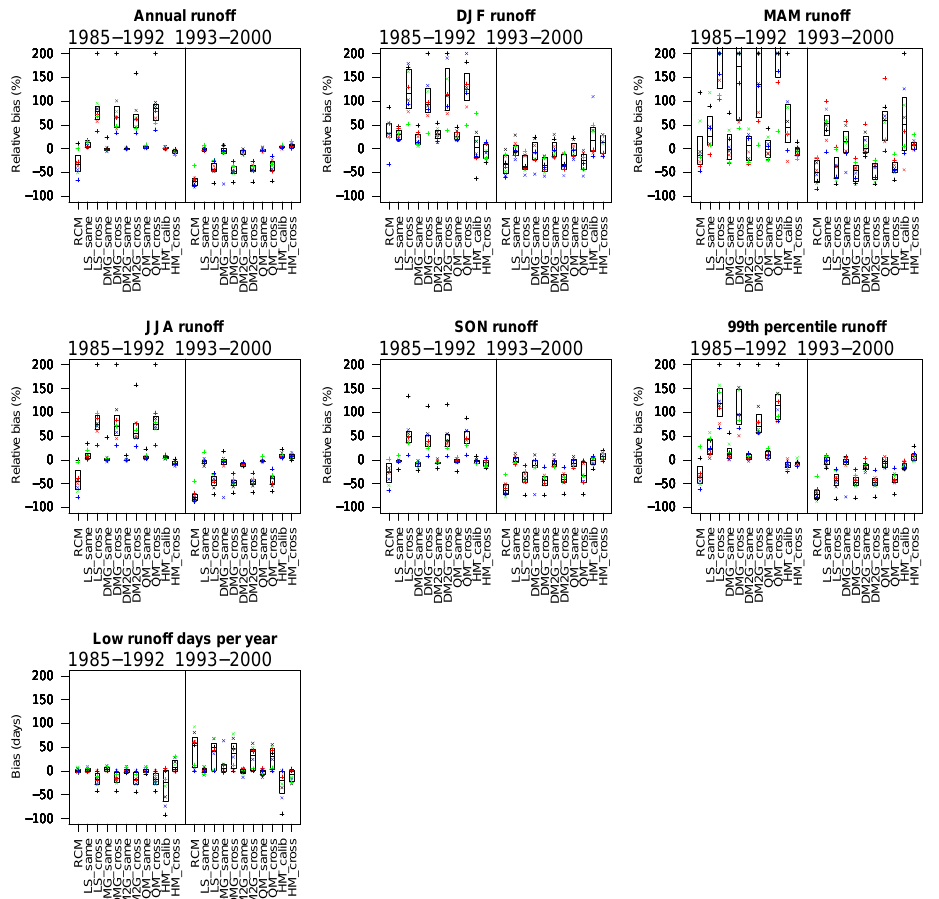
Figure 4. Relative bias in runoff characteristics derived from precipitation-driven hydrological model GR4J. Values are percentage differ- ences, relative to runoff modelled from observed precipitation, when GR4J was driven by raw RCM precipitation and bias corrected RCM precipitation. Same layout as Fig. 3, with additional HM_calib and HM_cross, which represent calibration errors and cross-validation errors from GR4J